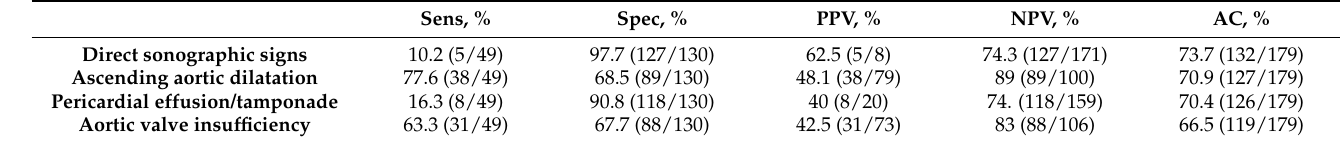
Figure 2. Proportion of PHHE signs in 49 A-AAS cases. Table 2. Diagnostic performance of each sign of PHHE-FOCUS.